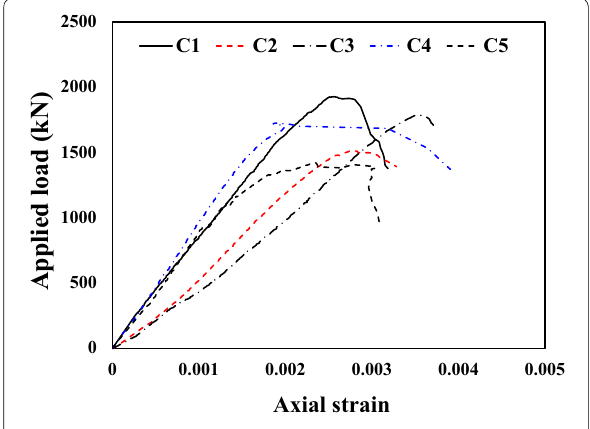
Fig. 6 Applied load—axial strain